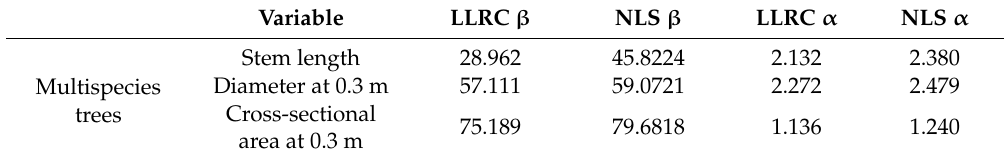
Table 5. Regression coefficients to predict total AGB for multispecies trees with LLRC and NLS.